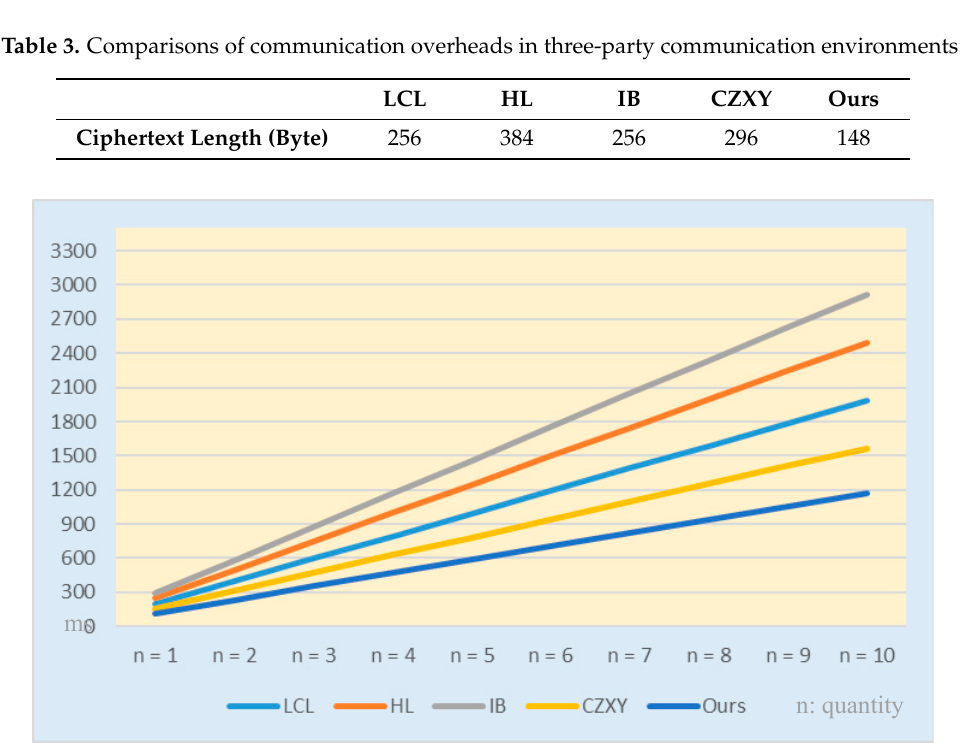
Figure 1. Comparison of computational costs among different quantities of ciphertext in the three-party communication environment.